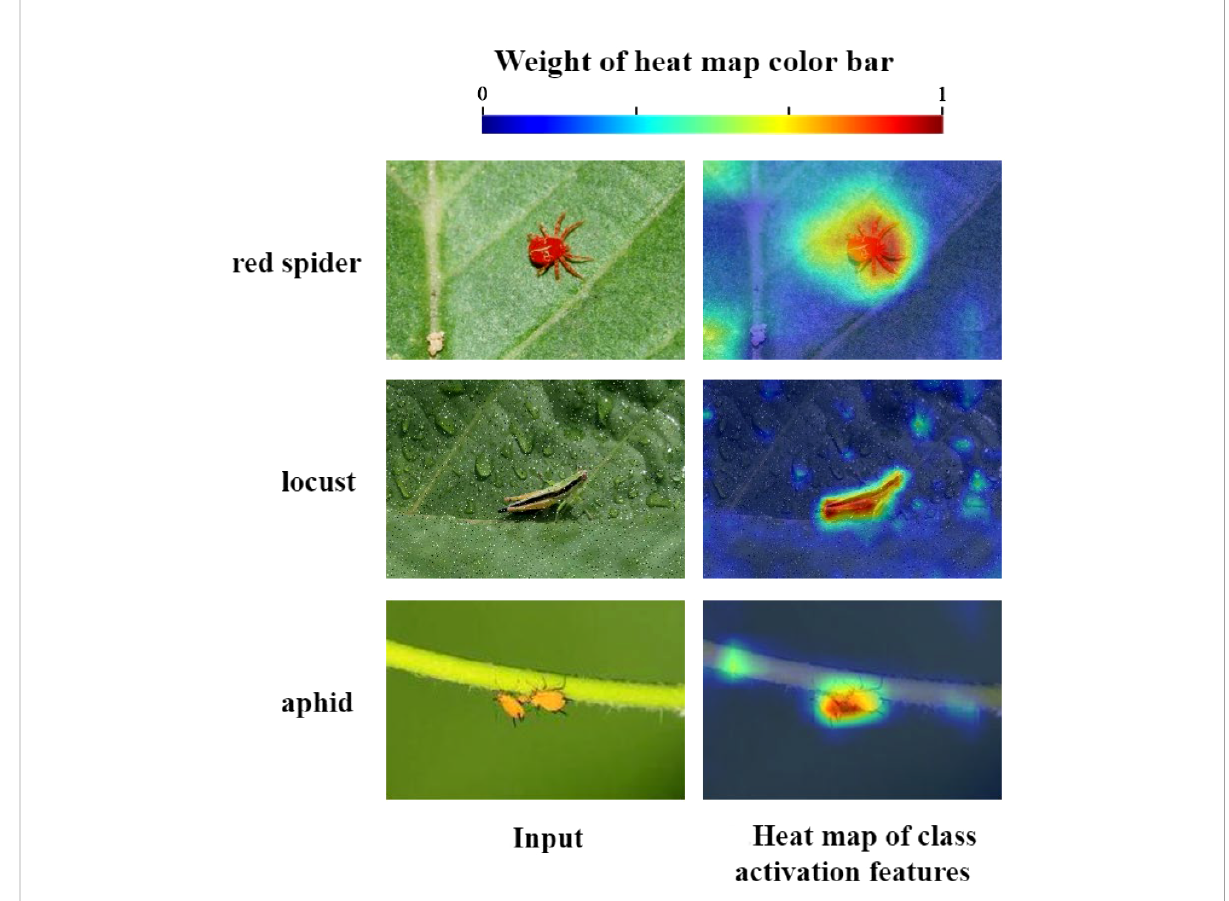
FIGURE 12 Heat map of the output after adding the feature processing